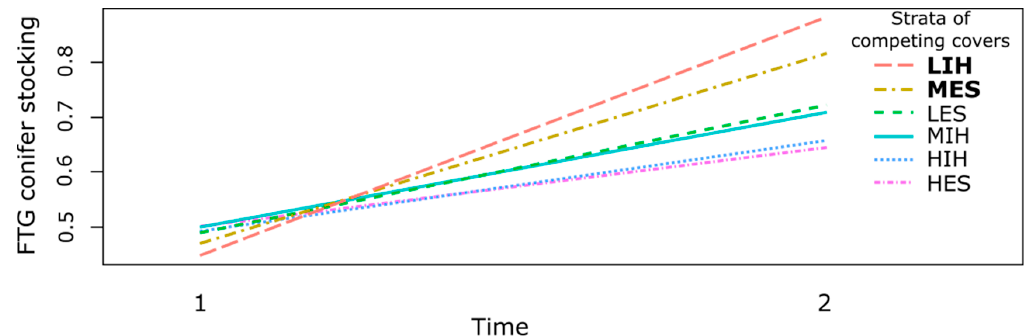
Figure 4. Free-to-grow conifer stocking per strata of competing cover and over two time periods. LIH: low competing level of commercial shade-intolerant hardwoods, MIH: moderate competing level of commercial shade-intolerant hardwoods, HIH: high competing level of commercial shade-intolerant hardwoods, LES: low competing level of ericaceous shrubs, MES: moderate competing level of ericaceous shrubs, HES: high competing level of ericaceous shrubs. Bold indicate significance at α = 0.05.